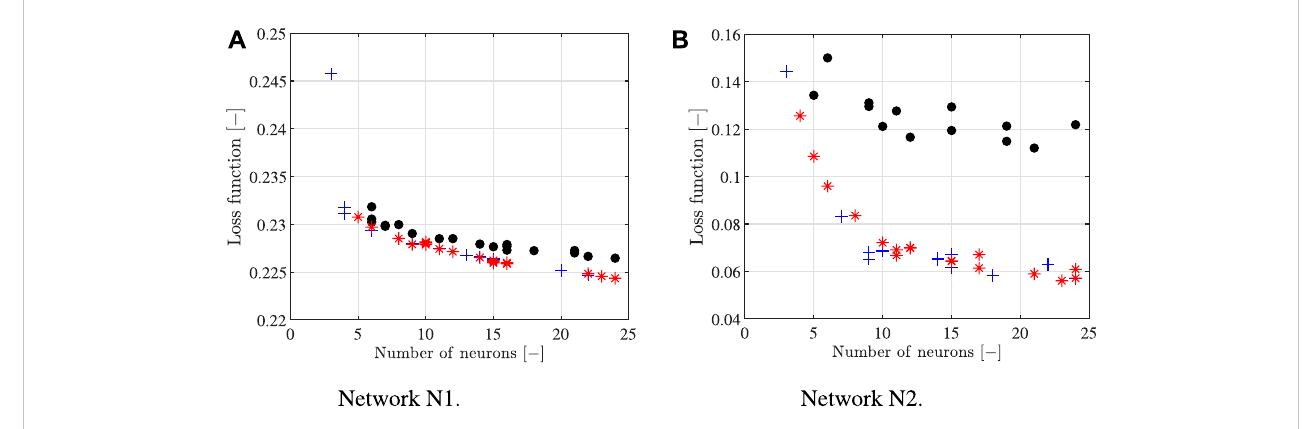
FIGURE 4 Numerical case study: performance of the networks with a single hidden layer in function of the number of neurons and the transfer function type; (A) (cid:129) Network N1 and (B) Network N2. Black : ReLU transfer function; blue +: Sigmoid logistic transfer function; red p : hyperbolic tangent transfer function.